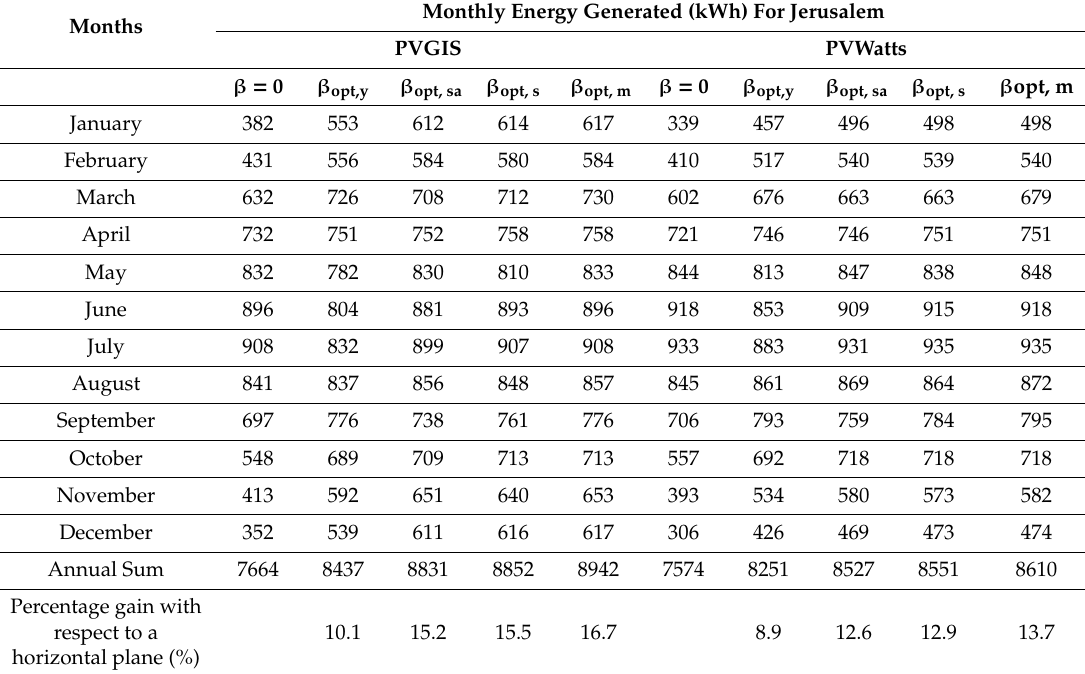
Table 17. Monthly energy generated by a 5 kWh system in Jerusalem.